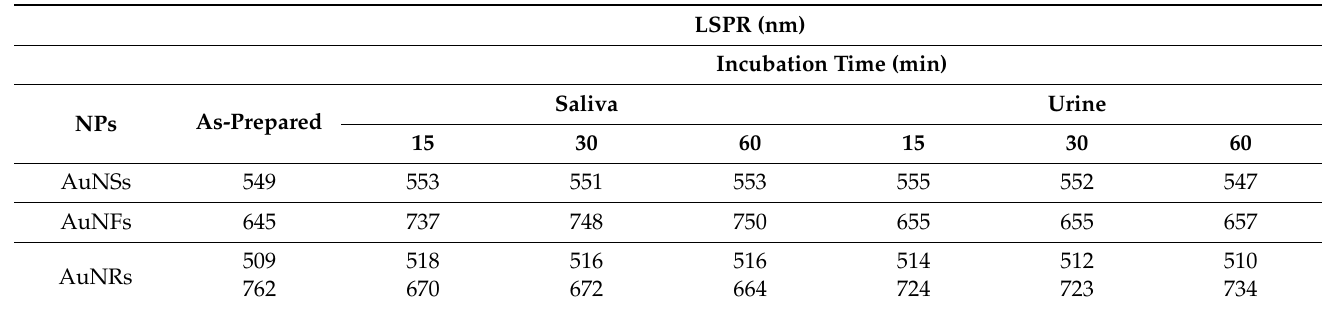
Table 1. Wavelength of the LSPR band of Au NPs, before and after the incubation with the biofluids for 15, 30, and 60 min. LSPR (nm) Incubation Time